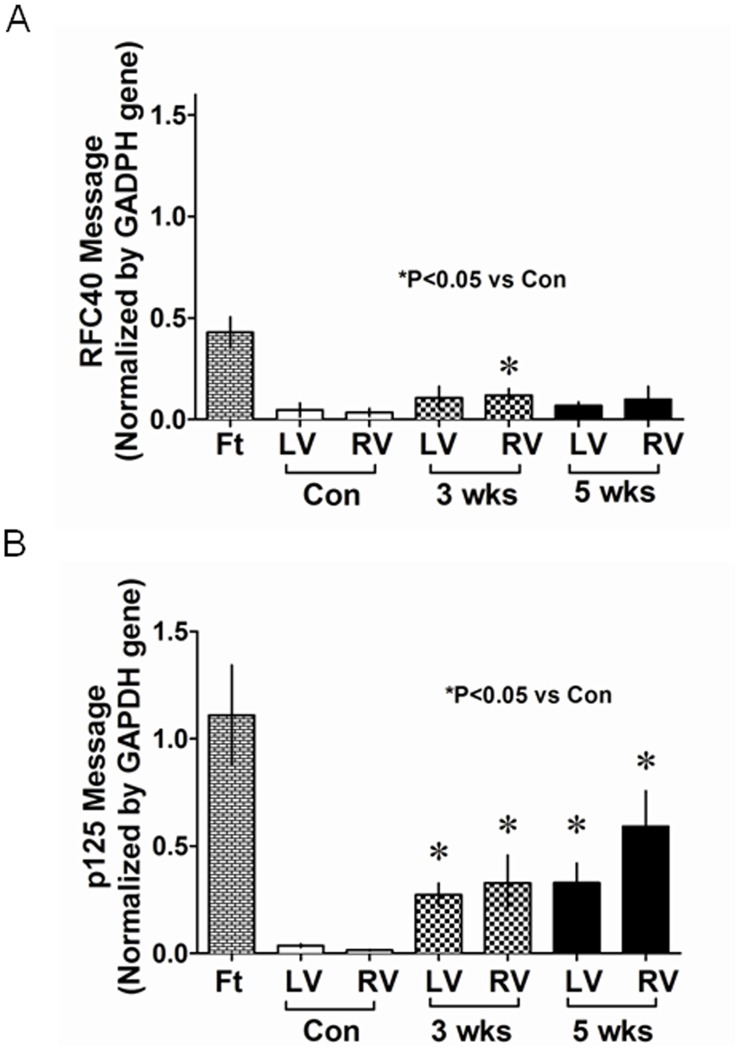
Up-regulation/re-expression of replication proteins in hypertrophied hearts occurs at the transcription level.Total RNA (50 ng) extracted from LV and RV tissues (n = 5) of the control (Con), SUHx-3 wks (3 wks) and SUHxNx-5 wks (5 wks) was subjected to real-time one-step-RT-PCR. The amplified products of RFC40, p125, and GAPDH mRNA/cDNA were visualized on 3% agarose gels at the end of each run. Total RNA extracted from whole hearts of 15 day-old fetus (n = 5) were used as a positive control (Ft). Graphs represent the changes in the mRNA levels for RFC40-mRNA (A) and p125-mRNA (B) calculated from the crossing point deviation of all the samples and normalized by GAPDH values. Values are mean ± SE. *indicates P<0.05 vs. control.